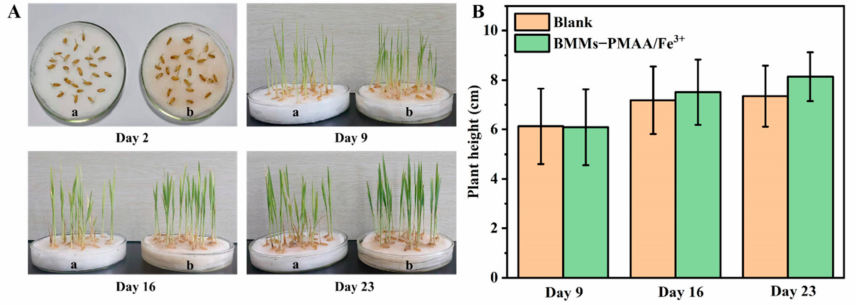
Figure 9. Growth photographs ( A ) and heights ( B ) of rice plant with BMMs − PMAA/Fe 3+ treatment on different days.